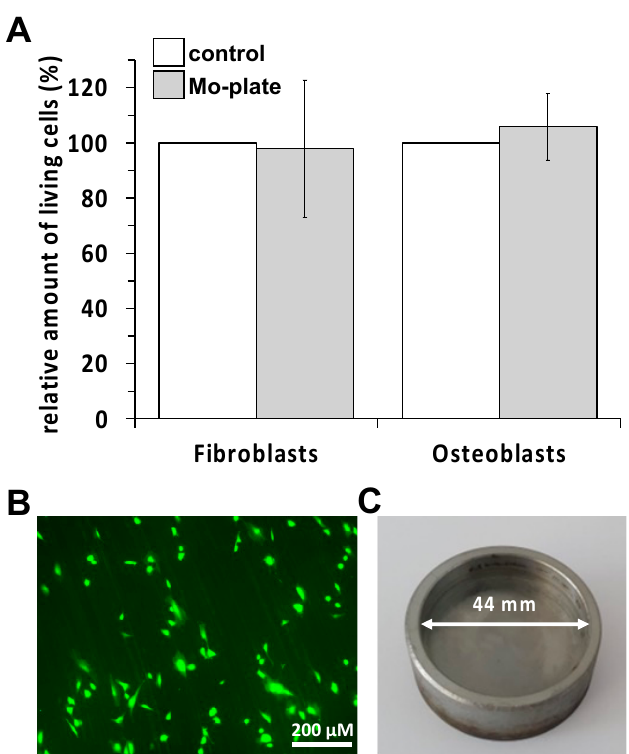
Figure 1. ( A ) Vitality of human skin fibroblasts and osteoblasts seeded on a molybdenum crucible in comparison to a Petri dish (control). ( B ) Positive fluorescein diacetate (FDA) staining of living adherent osteoblasts on the molybdenum crucible. ( C ) Representation of the size of the molyb- denum crucible used.